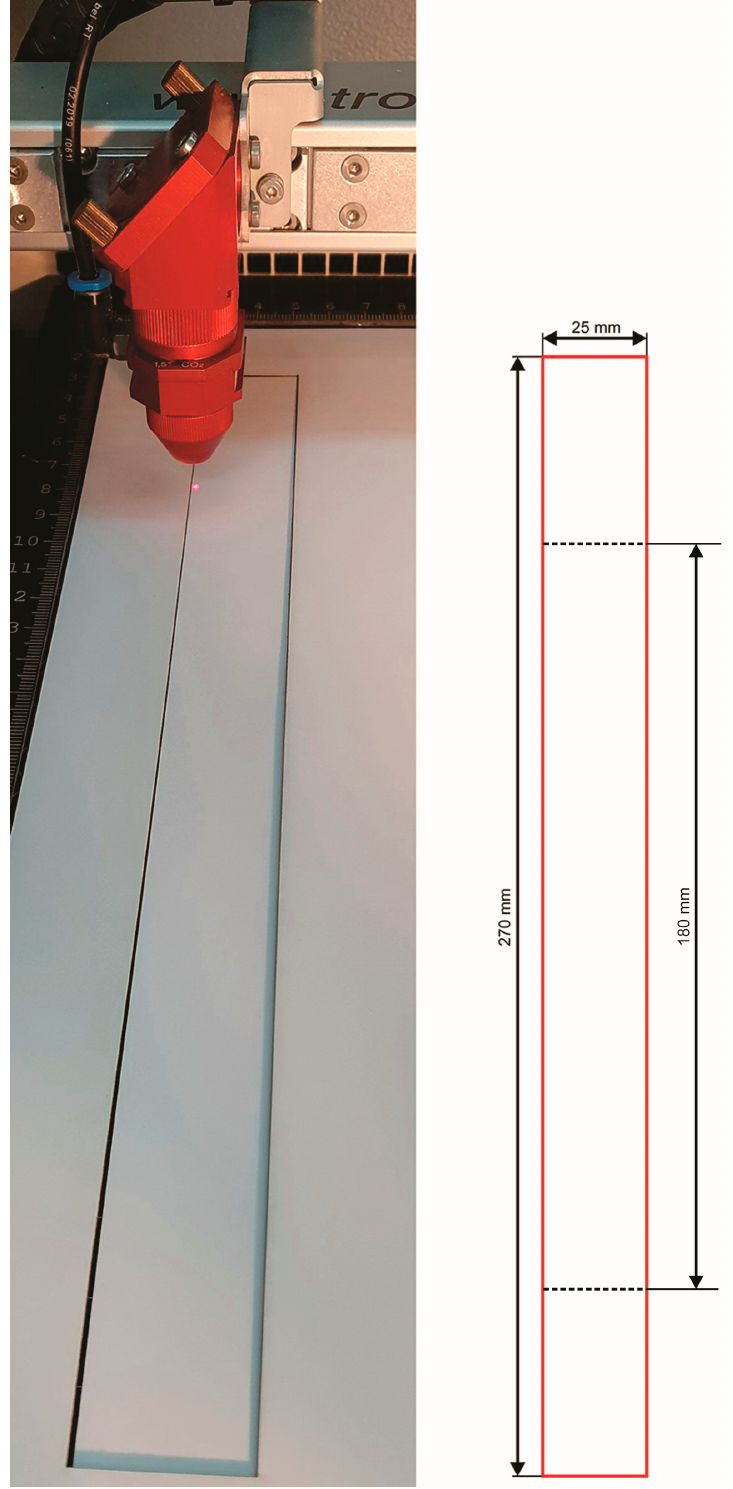
Figure 3. Experimental specimen.